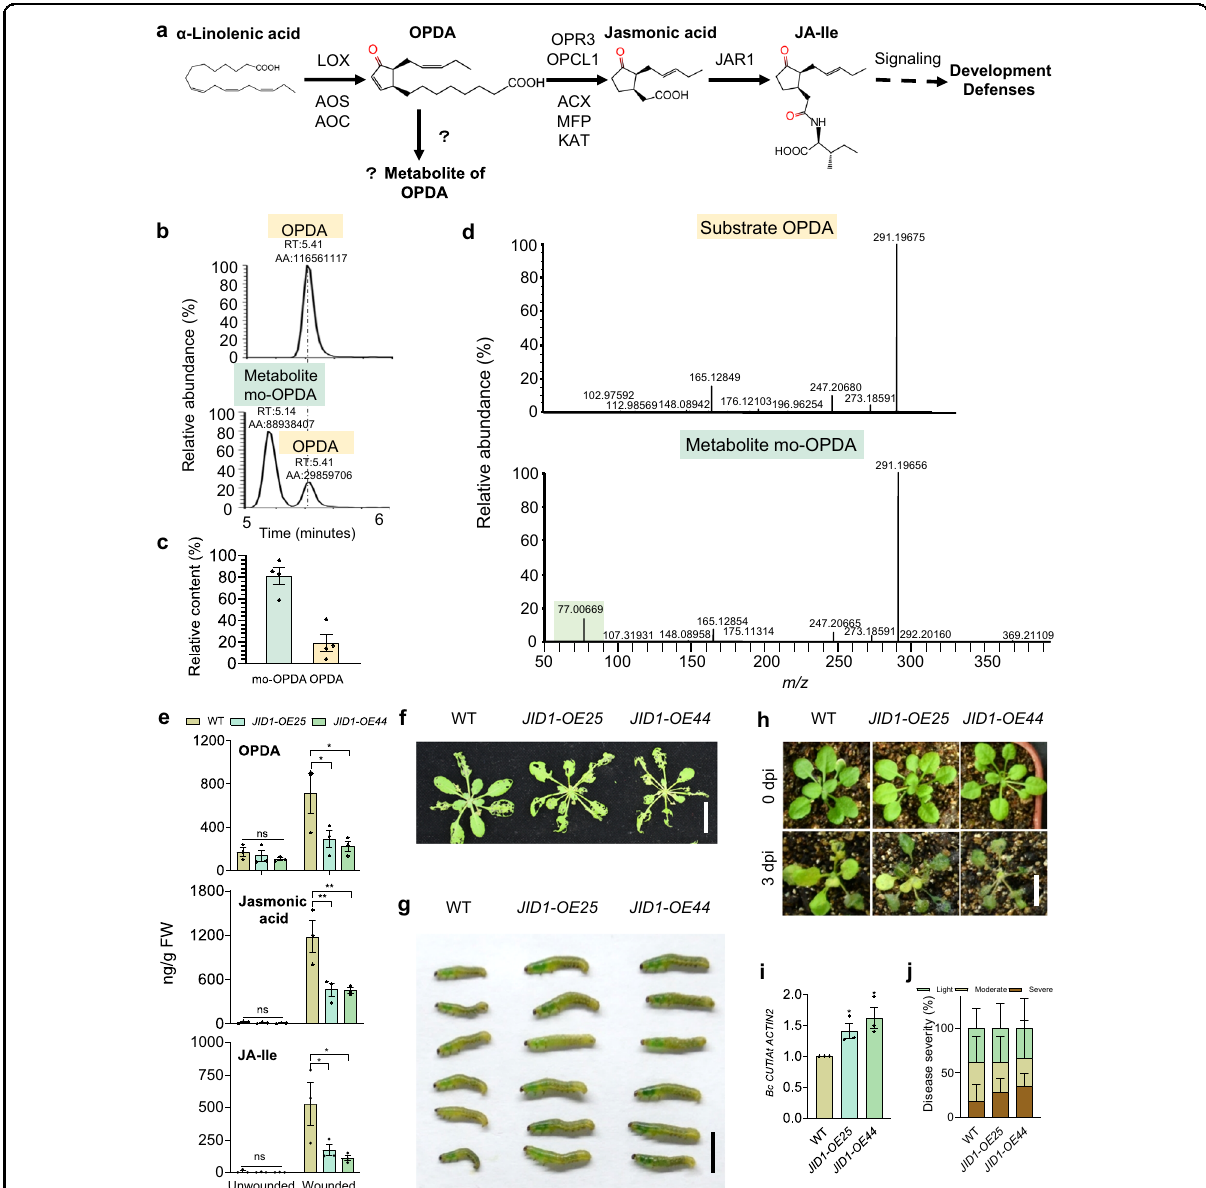
Fig. 1 JID1 modi fi es OPDA to regulate plant defense responses. a Schematic of JA biosynthesis. Enzymes involved in JA biosynthesis are indicated. The enzyme(s) involved in the catalysis of OPDA is unclear. b LC-MS/MS analysis of residual OPDA and produced mo-OPDA after incubation with empty vector (top panel) or af fi nity-puri fi ed JID1 protein (bottom panel) respectively, monitored by UHPLC-QE/MS. RT, retention time; AA, peak area. c Relative contents of substrate OPDA and product mo-OPDA after incubation with JID1 protein. Relative content was calculated by the ratio of residual OPDA or produced mo-OPDA peak area relative to that of initial OPDA. The initial content of OPDA was set as 100%. Data are means ± SEM ( n = 4). d MS/MS spectra of substrate OPDA (top panel) and product mo-OPDA (bottom panel) monitored by UHPLC-QE/MS. The m/z 77.00669 fragment of mo-OPDA is indicated in green. e JA pro fi les of plants without (Unwounded) or with mechanical wounding (Wounded) for 1 h. Data are means ± SEM ( n = 3). Two-way ANOVA, Tukey ’ s post-hoc test, ns, P > 0.05, * P ≤ 0.05, ** P ≤ 0.01. f , g Representative phenotypes of attacked plants ( f ) and S. exigua larvae ( g ) are shown. Scale bars, 2 cm ( f ), 5 mm ( g ). h – j Disease symptoms of plants ( h ), quanti fi cation of B. cinerea biomass ( i ), and disease severity of plants ( j ) are shown. Scale bar, 1 cm ( h ). Data are means ± SEM ( n = 3). Student ’ s t -test, * P ≤ 0.05. dpi, days